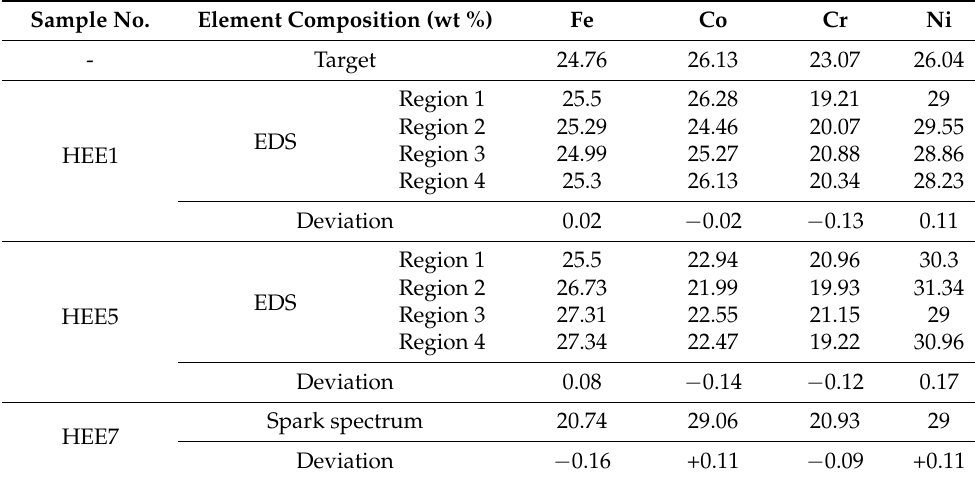
Table 3. Chemical composition of as-printed samples using EDS (energy dispersive spectroscopy) line scanning and spark